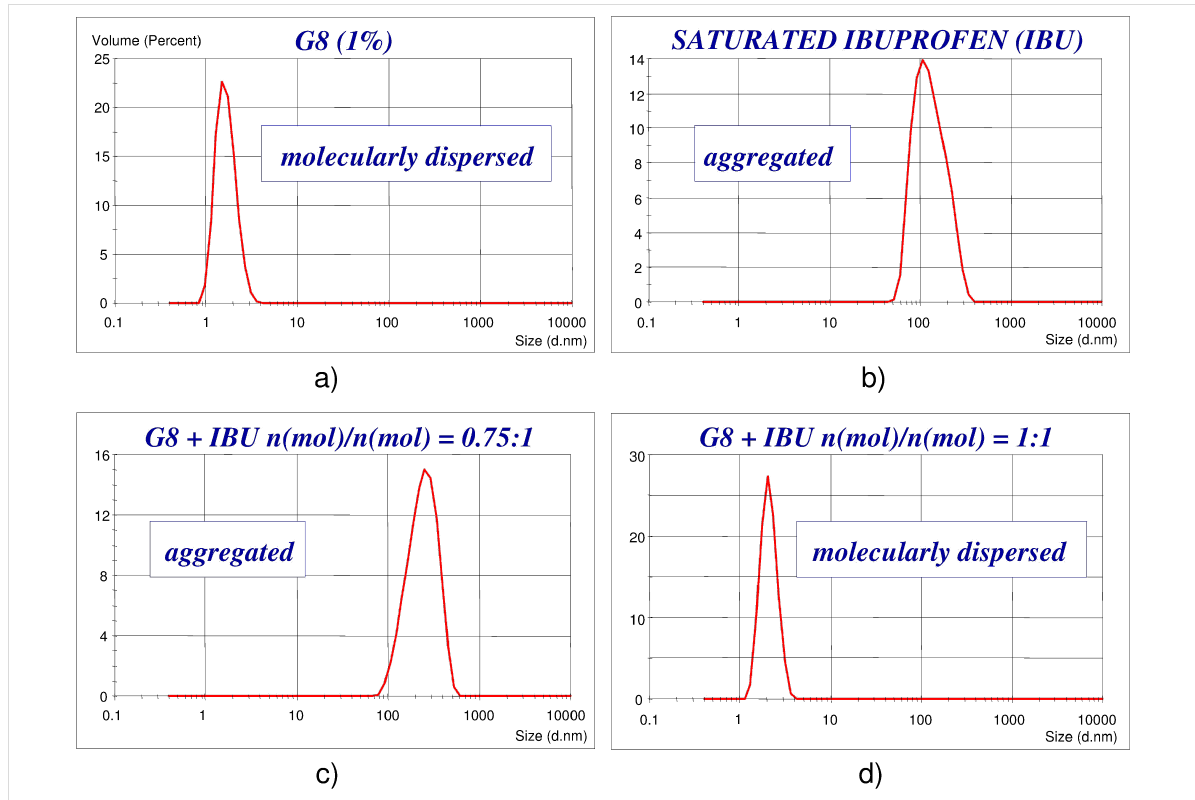
Figure 1: Aggregate size analysis of aqueous solutions of G8 and ibuprofen by PCS. a) G8 in 1% solution; b) saturated ibuprofen solution; c) combining ibuprofen and G8 in substoichiometric ratio (1:0.75); d) combining ibuprofen and G8 in stoichiometric ratio